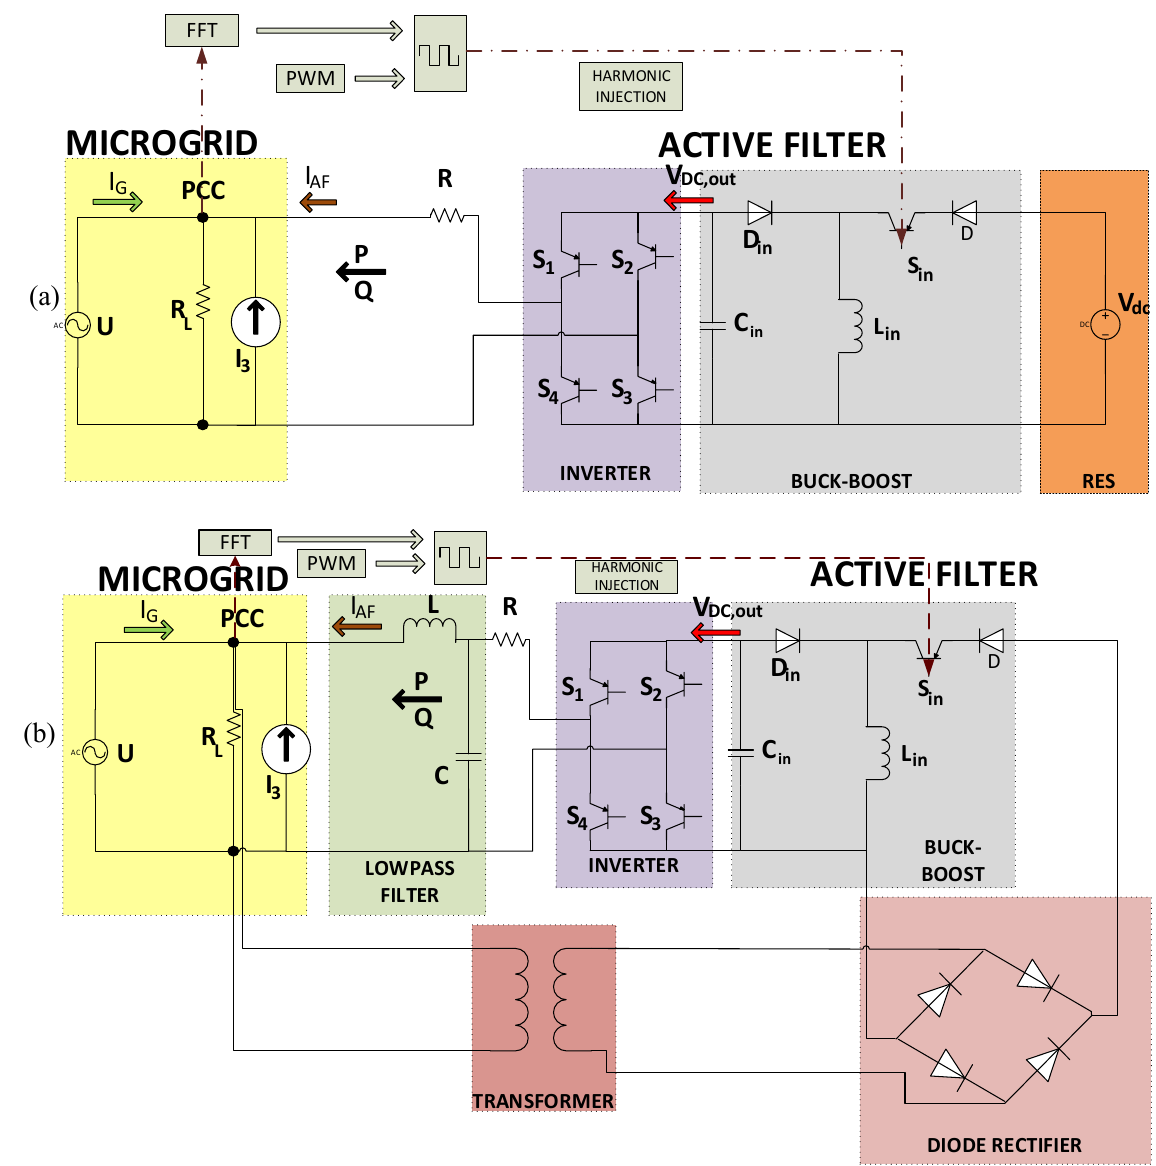
Figure 1. ( a ) Configuration of the studied system in the first case; ( b ) Configuration of the studied system in the second